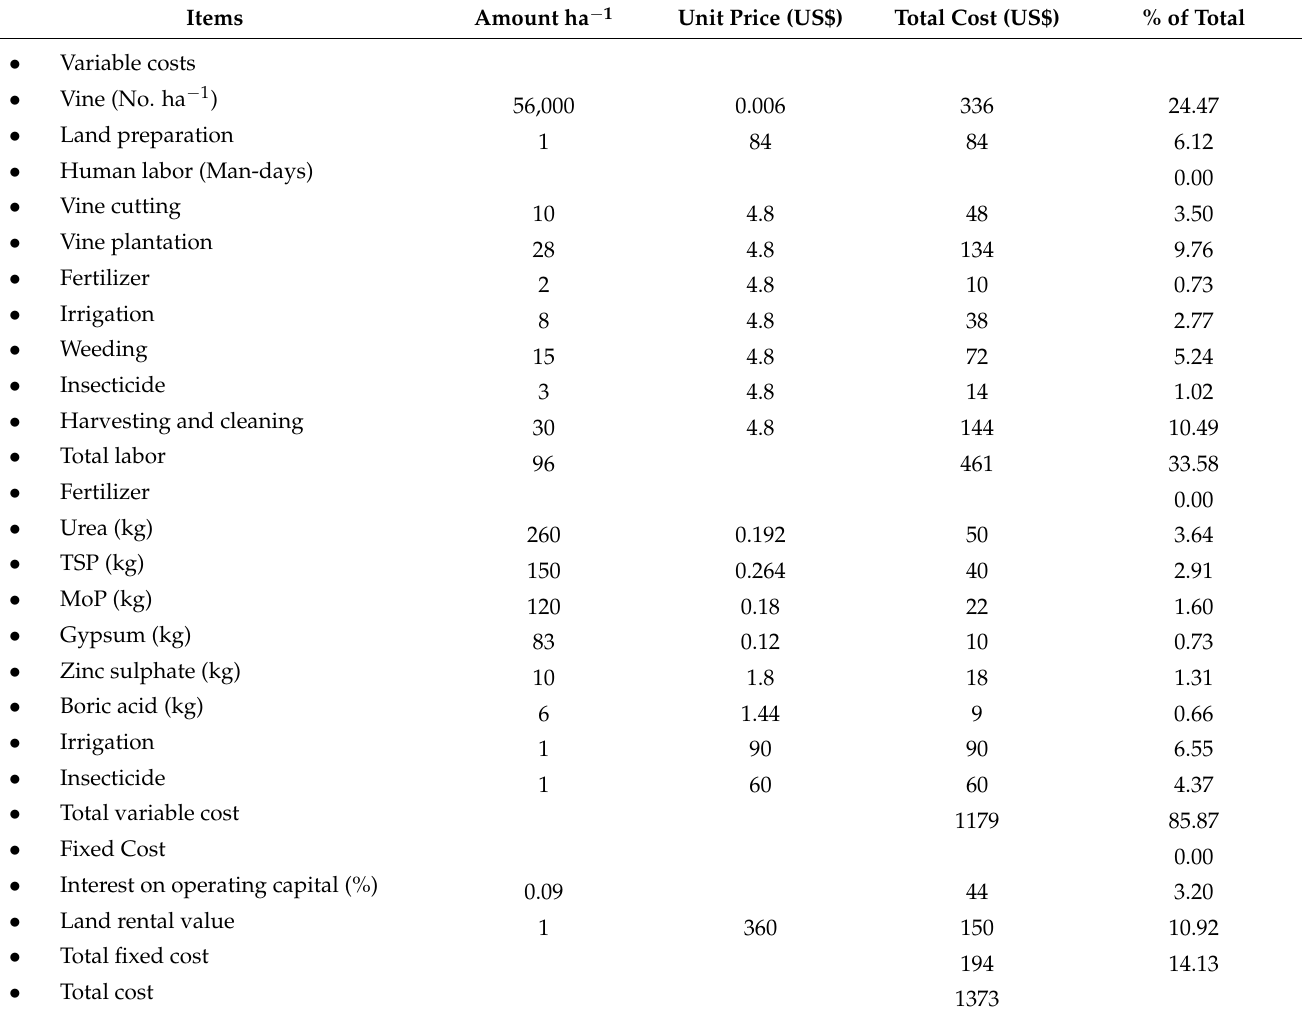
Table 3. The production cost of sweet potato used in the economic